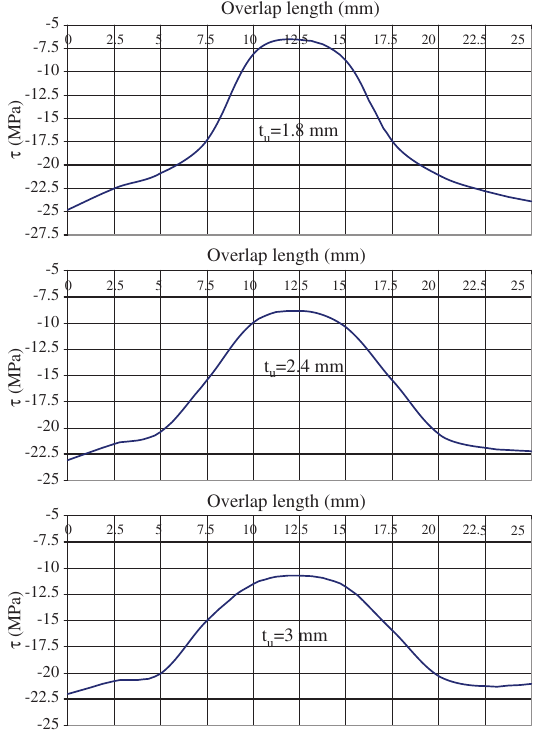
Figure 6 Shear stress distribution under elastoplastic loading for adhesive length of 2 L = 20 mm and adhesive thickness of = 0.14 t a